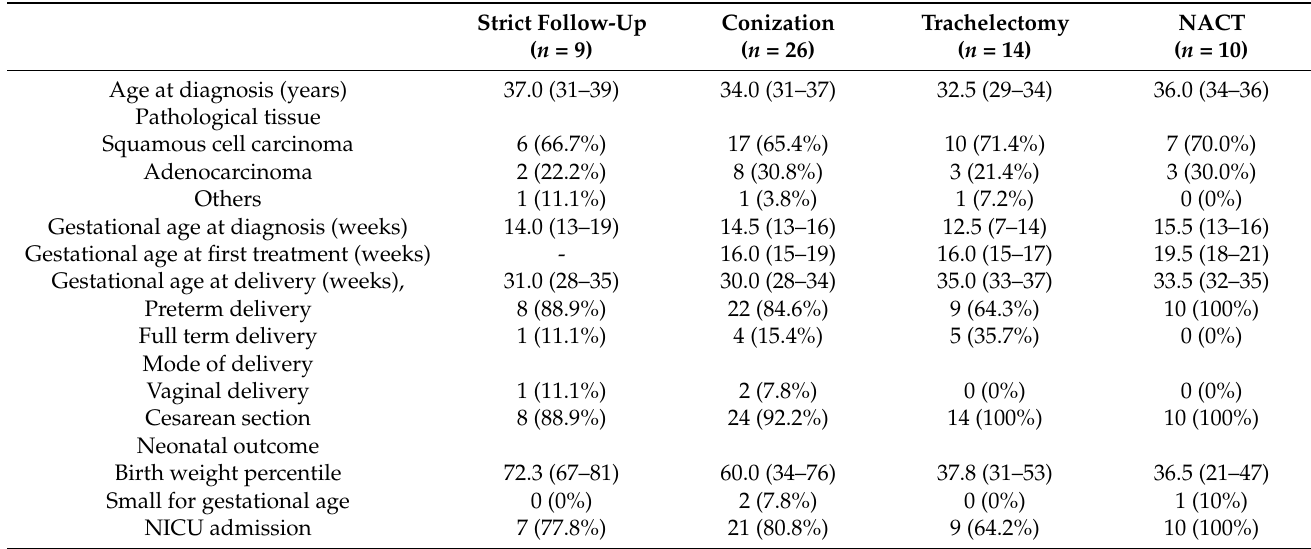
Table 3. Comparison of the clinicopathological data among the four groups of patients with stage IB1 cervical cancer diagnosed at <22 weeks of gestation.